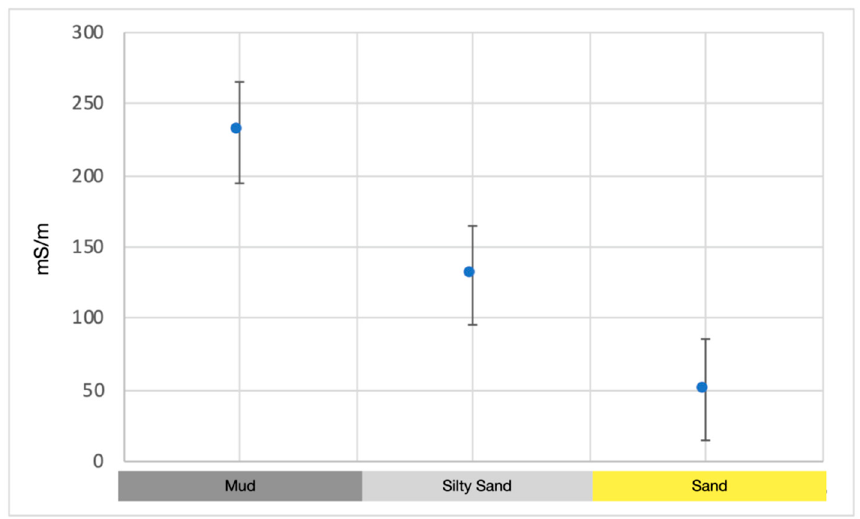
Figure 9. Plot of the interpretation of the EMI inverted conductivity intervals after the correlation with the sedimentary cores AV_1, AV_a, AV_b and